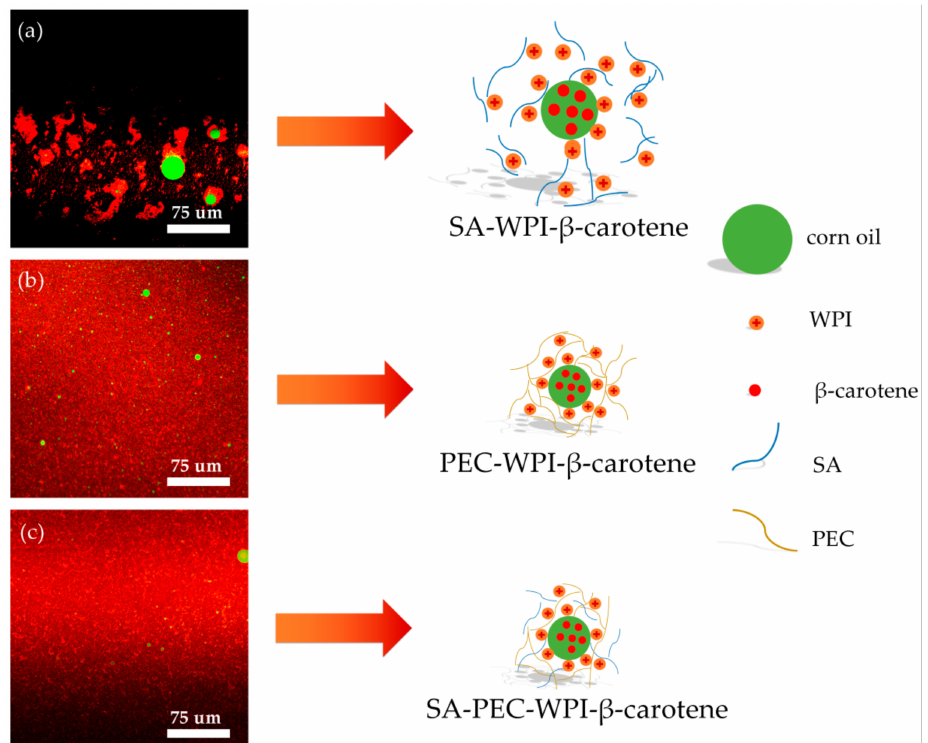
Figure 3. The CLSM images of SA-WPI ( a ), PEC-WPI ( b ), and SA-PEC-WPI ( c ) stabilized β -carotene emulsions. CLSM: confocal laser scanning microscope; SA: sodium alginate; PEC: pectin; WPI: whey protein isolate.